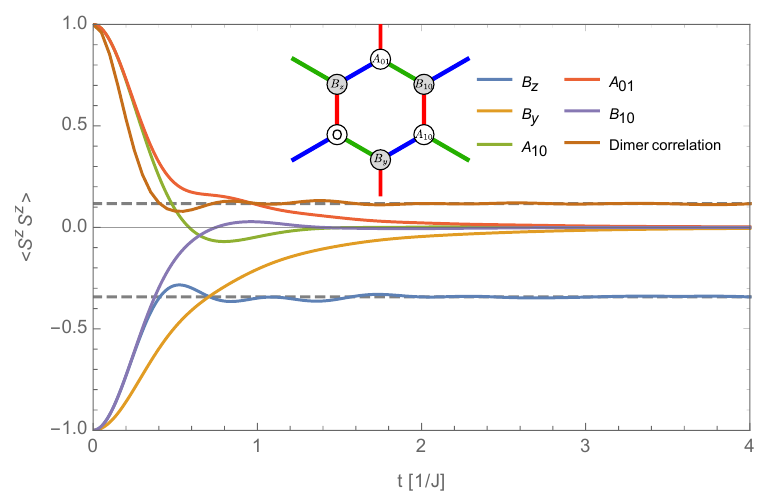
σ z 〉 for various short-range spins, in Figure 5: The static spin-spin correlations 〈 σ z i j = 2000. After a short time all spin correla- the isotropic model, with L = 8 and N mc tions vanish except the nearest-neighbor correlation along a z -bond. The long-range dimer-dimer correlation function, here measured at the longest possible distance be- tween two sets of z -bonds, also obtains a nonzero steady state value. These correla- tions are indicative of a valence bond solid phase. [ 19